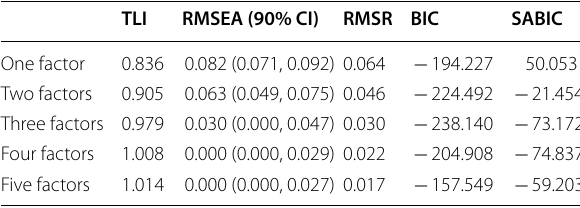
A good fit is defined by TLI > 0.95, RMSR < 0.05, and RMSEA < 0.06 with lower value of CI close to 0 and upper value no more than 0.08